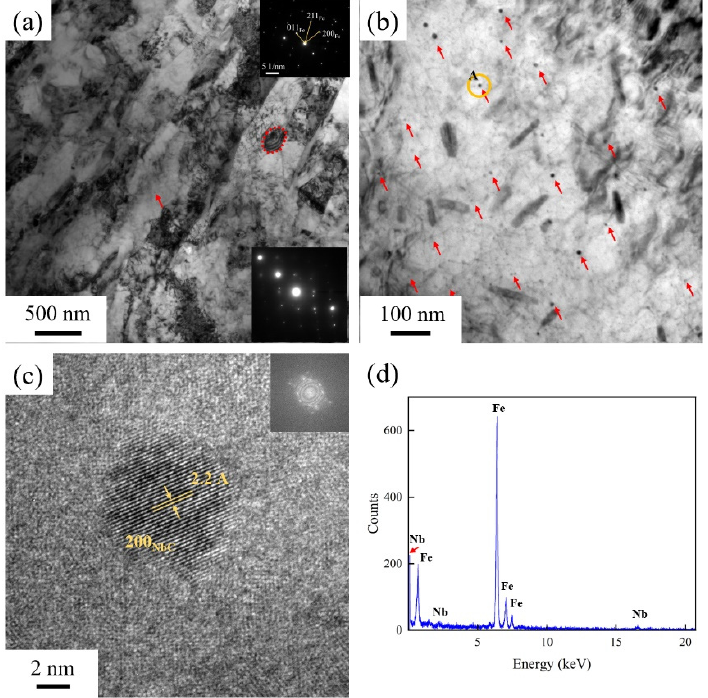
Figure 7. Precipitates in the HSLA steel: ( a ) BF TEM image; ( b ) distribution of the precipitates; ( c ) HRTEM of the precipitate; and ( d ) EDS analysis of the area A in Figure 7b.